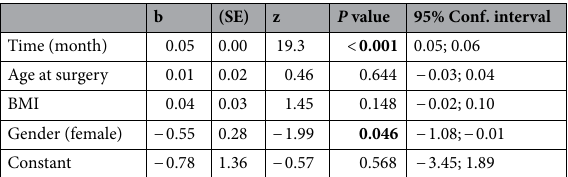
Table 2. Multivariate random effects model on the course of subsidence. Significant values are in [bold]. BMI Body mass index, SE Standard